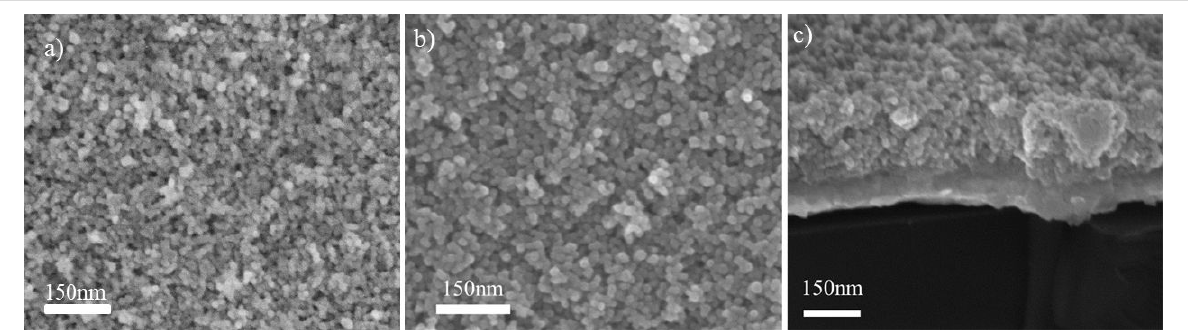
Figure 6: SEM images of Hf NPs film formed with energetic deposition and substrate bias: a) V s = 2 kV; b,c) V s = 4.5 kV, the porous structure of the film is revealed.